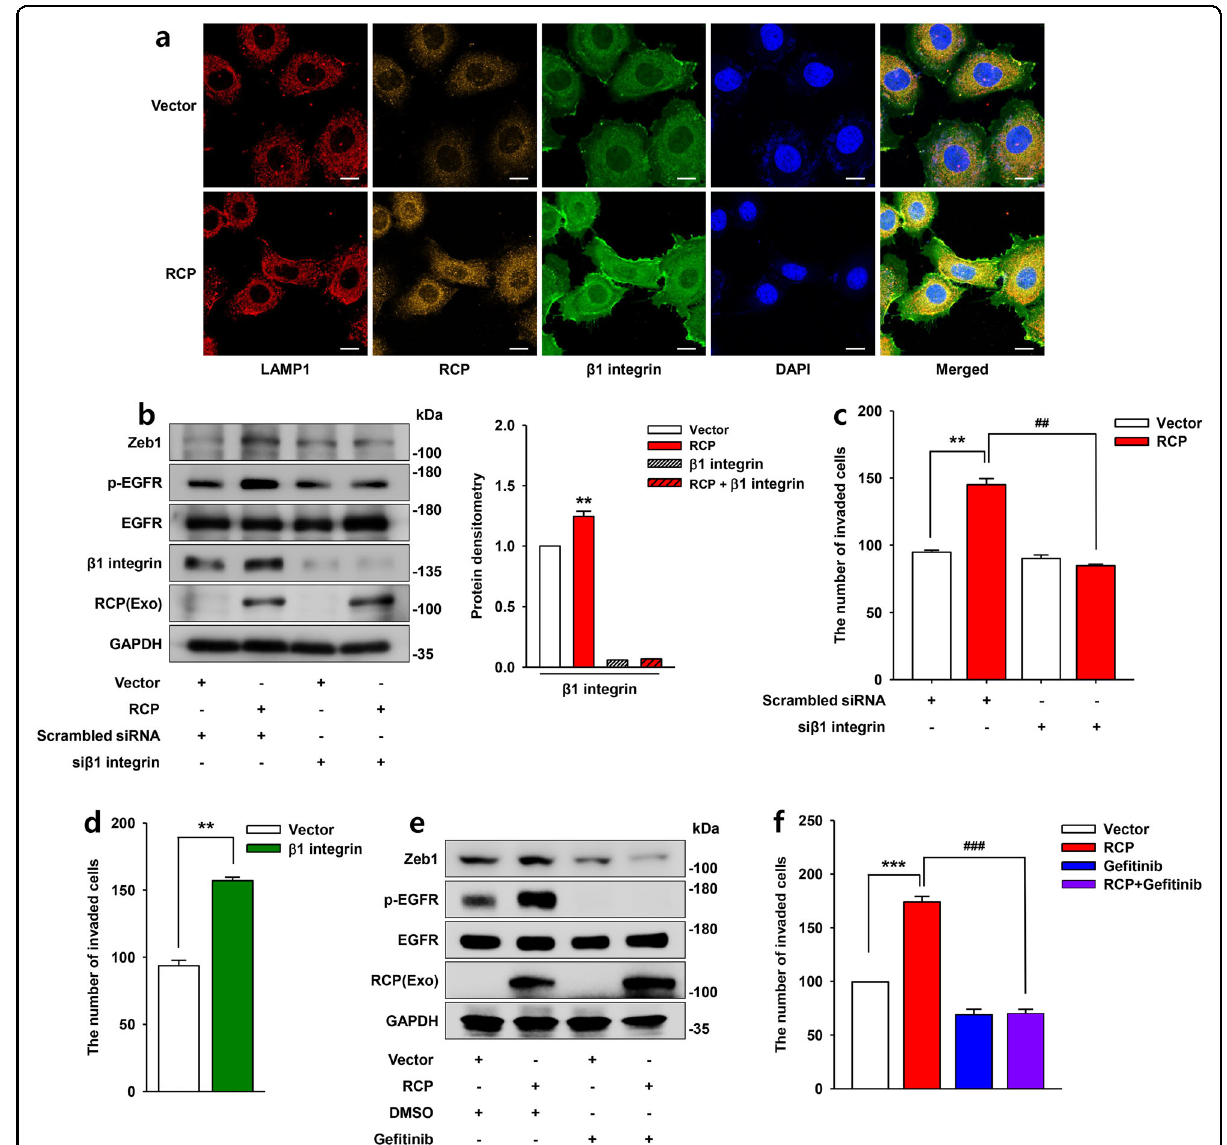
Fig. 3 RCP induces Zeb1 expression through the β 1 integrin/EGFR signaling axis. a The expression of β 1 integrin was visualized by immuno fl uorescence. Image original magni fi cation, ×600, scale bar, 10 μ m. b YD-10B cells were transfected with the indicated vectors and siRNAs. Immunoblotting. c , d YD-10B cells were transfected with the indicated vectors and siRNAs. Cell invasion assays were performed (error bars, ±SD: ** p < 0.01 vs control vector, ## p < 0.01 vs RCP). e YD-10B cells were sequentially transfected with or without RCP, serum-starved and treated with ge fi tinib (1 μ M) for 24 h. Immunoblotting. f YD-10B cells were transfected with RCP followed by pretreatment with ge fi tinib (1 μ M) for 1 h. Cell invasion assays were performed (error bars, ±SD: *** p < 0.001 vs control vector, ### p < 0.01 vs RCP). The results shown are representative of three experiments with similar results and indicate the mean ± SD of three